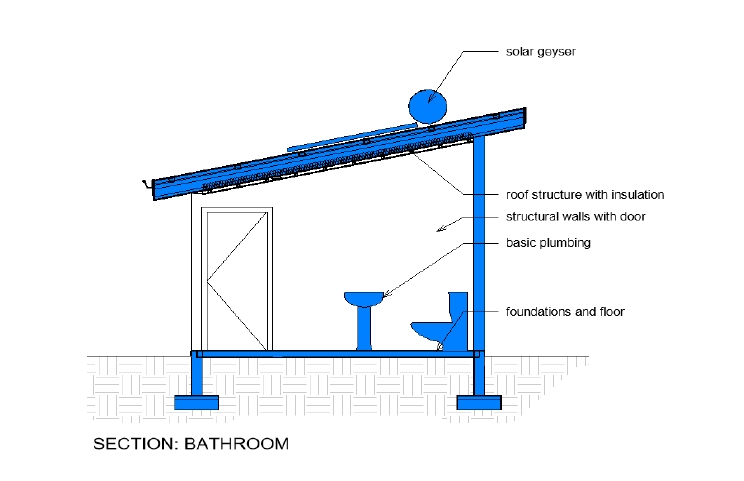
Figure 11: Primary level: Section through the bathroom. By author, 2022.